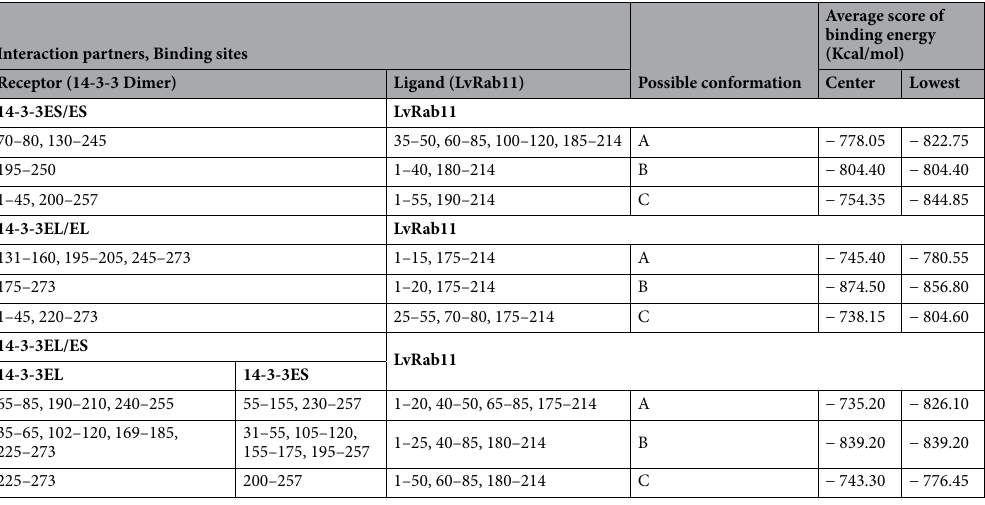
Table 2. Competitive binding simulation results for 14-3-3ε complexes and